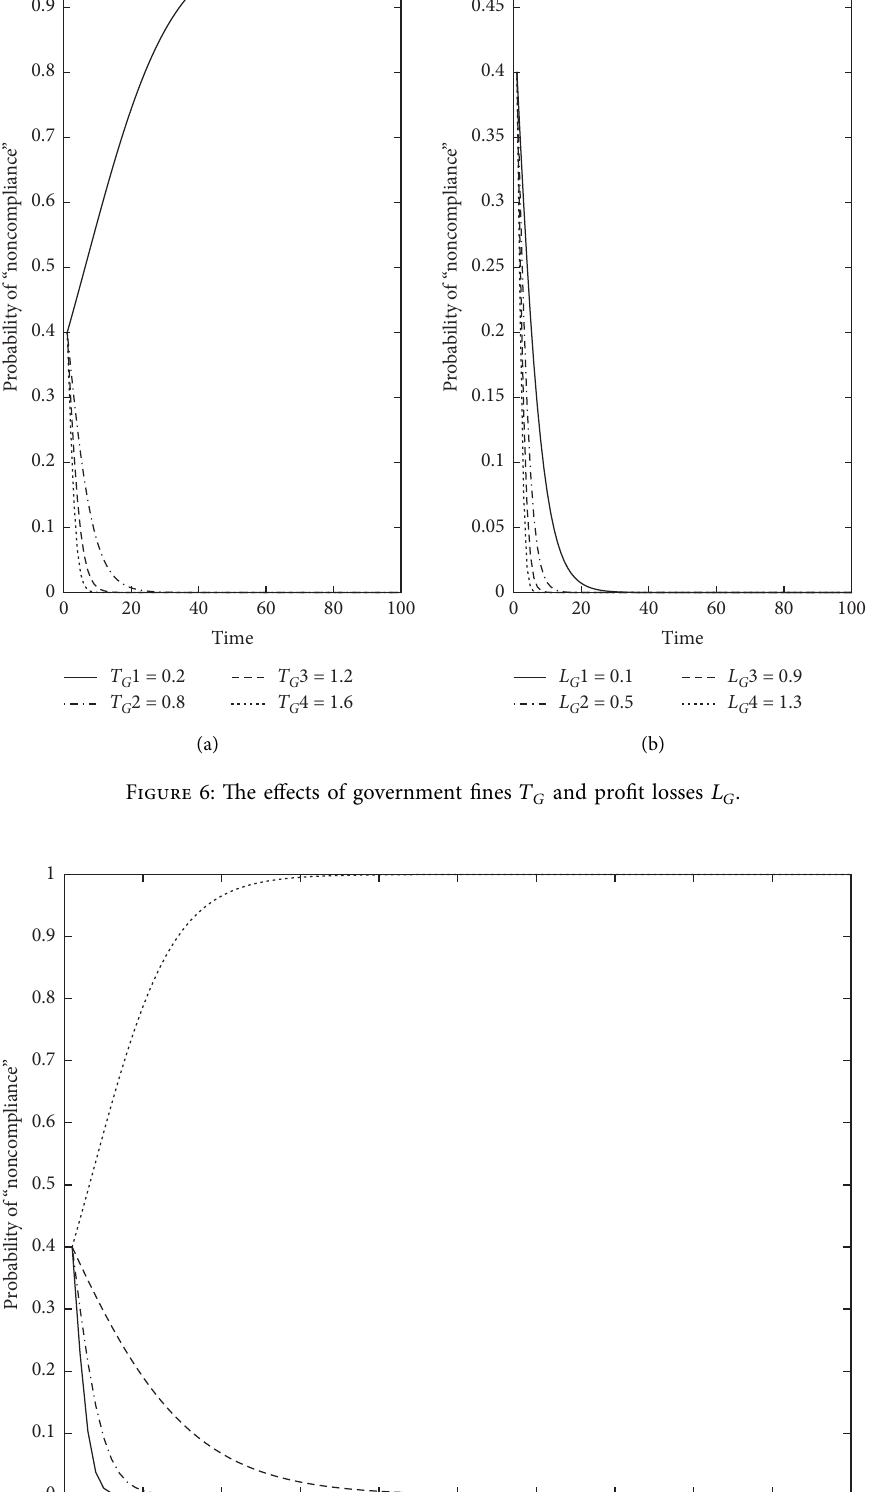
Figure 7: The effects of profits B